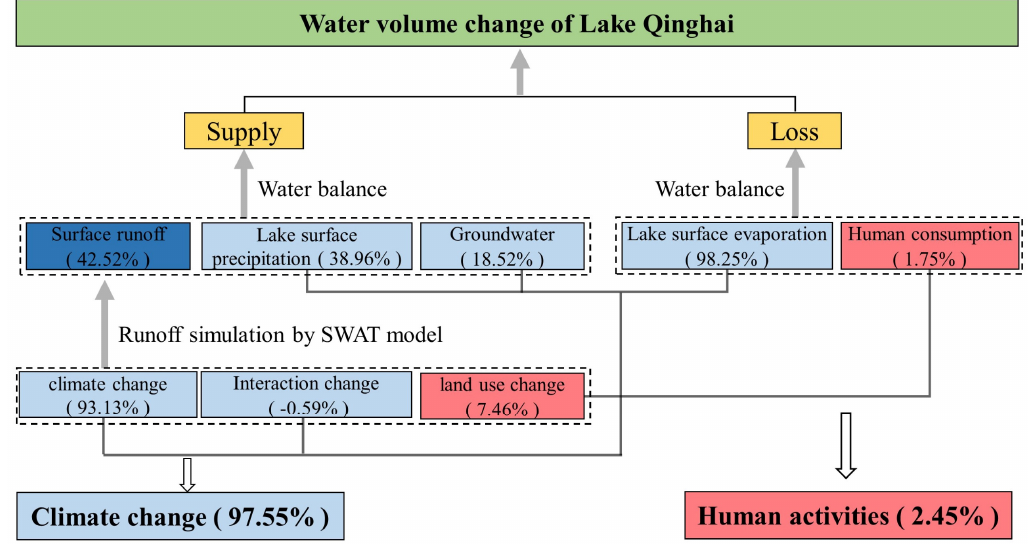
Figure 8. Contributions of climate change and human activities to the water volume change in Lake Qinghai. Light blue represents the impact of climate change, and pink represents the impact of human activities.